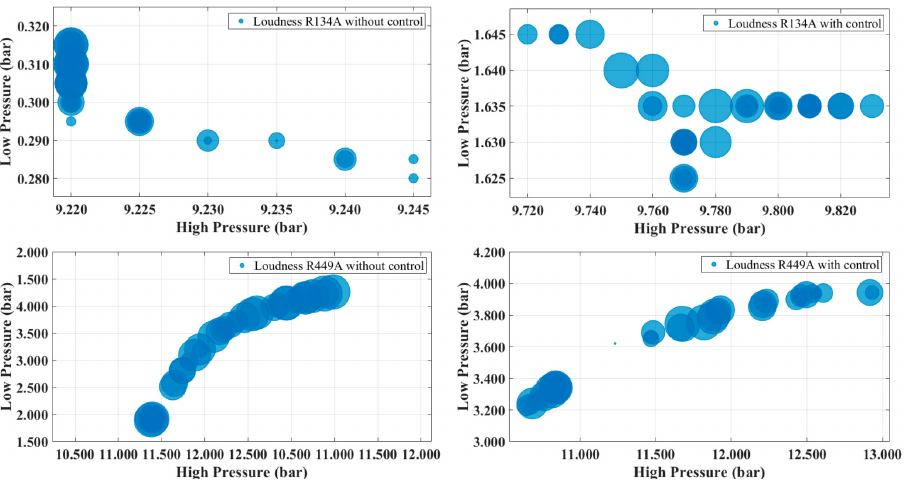
Figure 8. Relationship between loudness and working pressures for R-449A and R-134A refrigerant